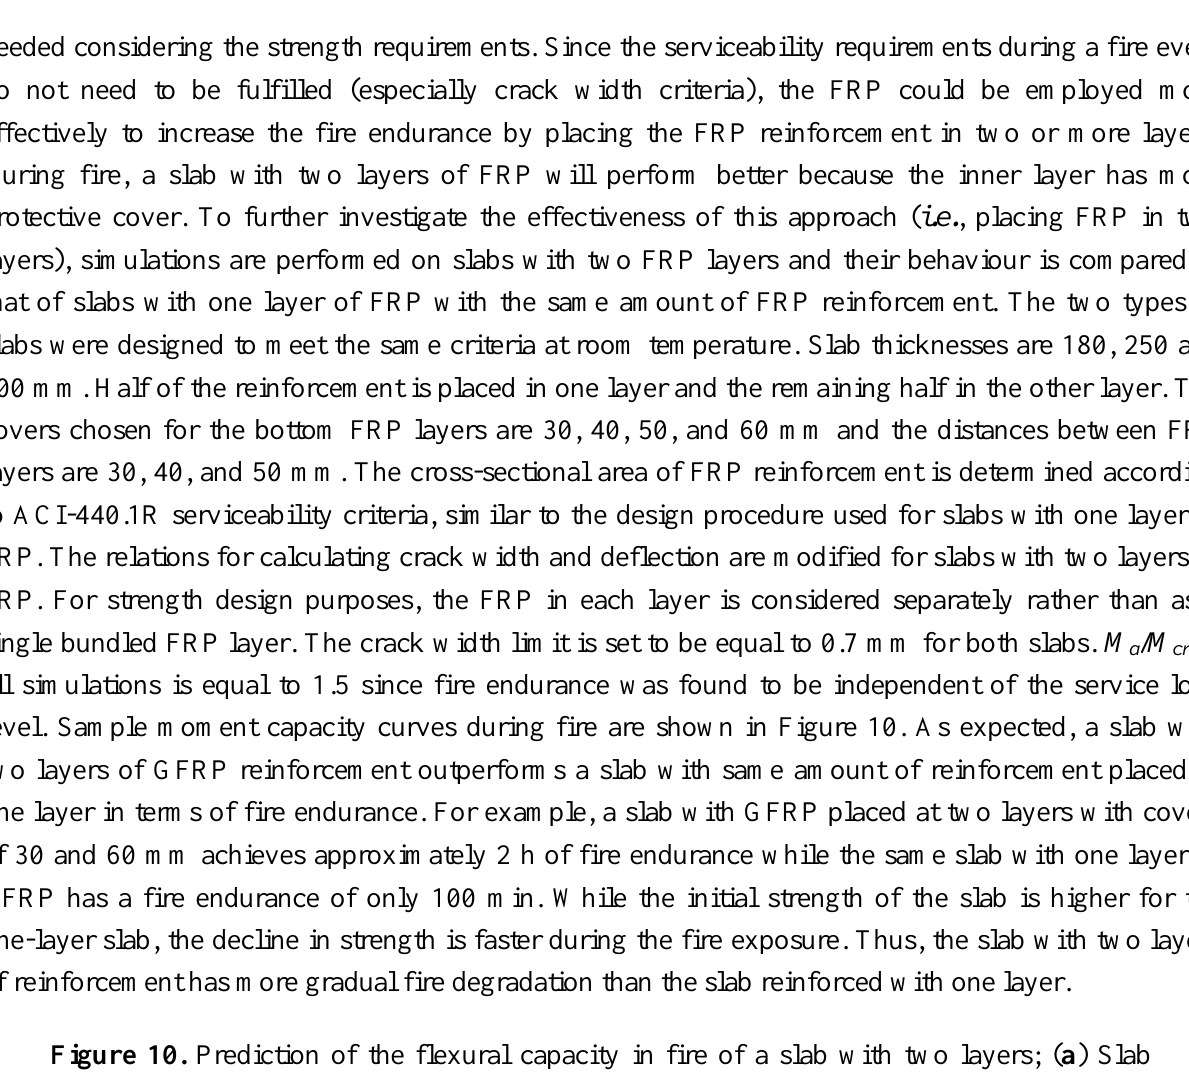
Figure 10. Prediction of the flexural capacity in fire of a slab with two layers; ( a ) Slab thickness of 180 mm; ( b ) Slab thickness of 250